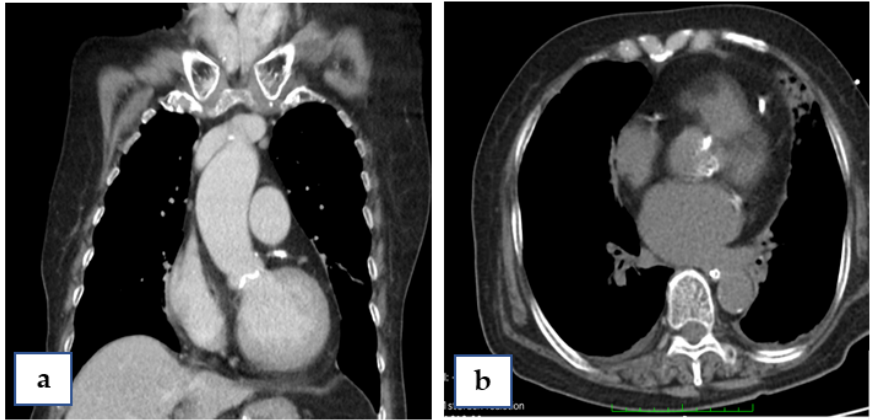
Figure 2. Computed tomography (CT) of the patient, sagittal view ( a ) and coronal view ( b ), showing calcification of the aortic annulus.